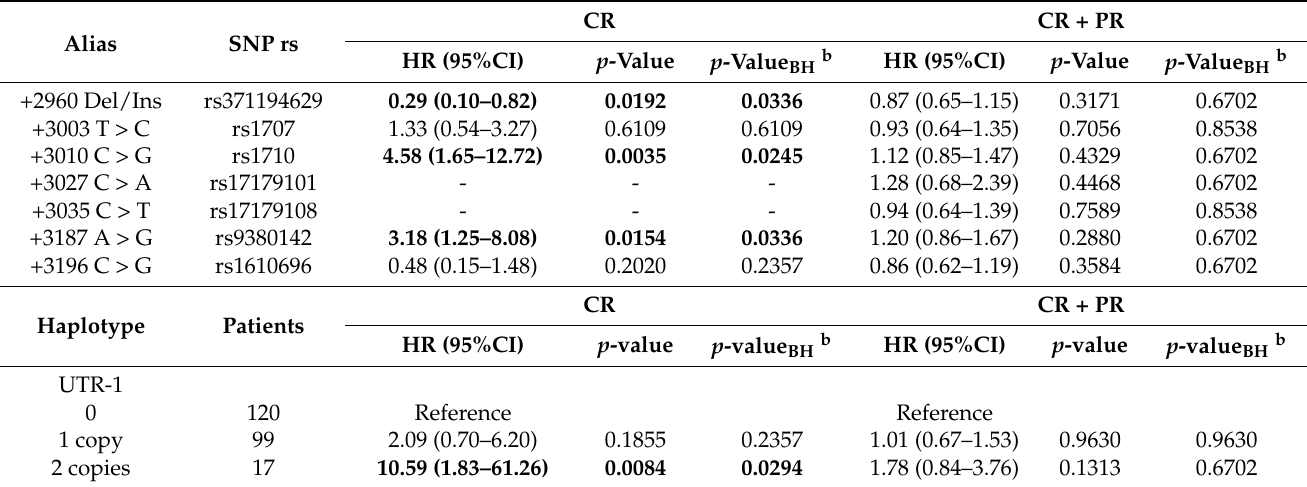
Table 3. Multivariable hazard ratio (HR) and corresponding 95% confidence intervals (CI) a for clinical response to treatment according to HLA-G 3 (cid:48) UTR polymorphisms (additive model) and UTR-1 haplotype.